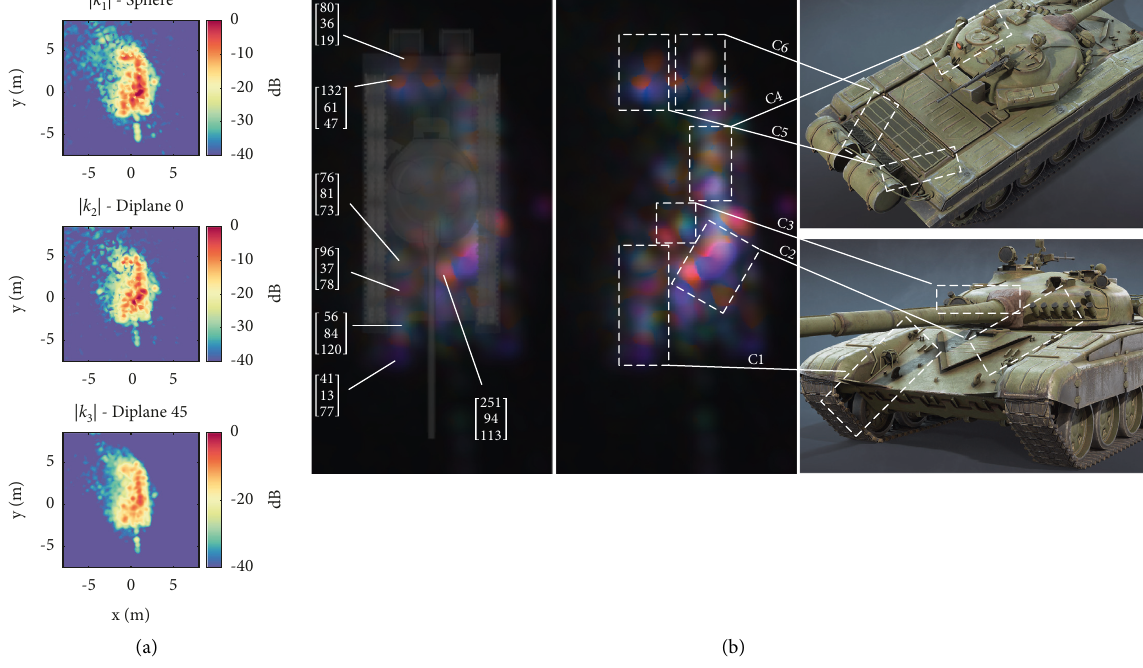
Figure 6: Pauli decomposition results. The three scattering components are displayed individually in (a) and as a composite RGB image in k G k B k (b) with R 2 | , 3 | , and 1 | . Sample [ R ; G ; B ] values and scattering regions C1 to C6 are also seen together with a 3D CAD model (cid:29) | (cid:29) | (cid:29) | used for illustration